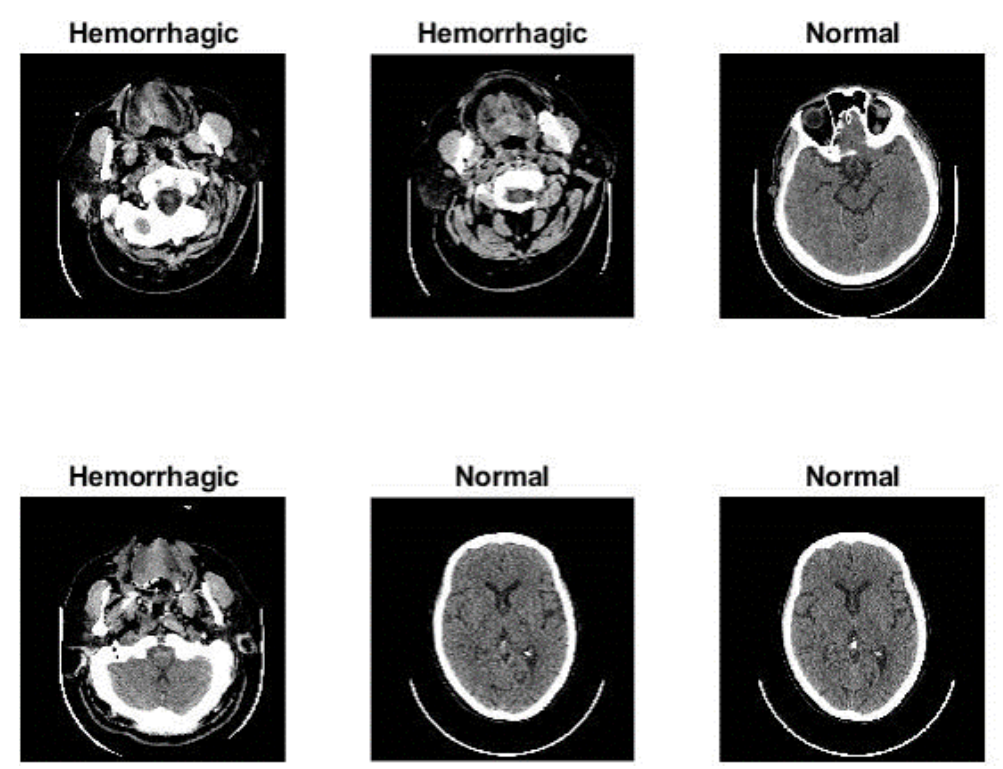
Figure 2. CT samples for the hemorrhage